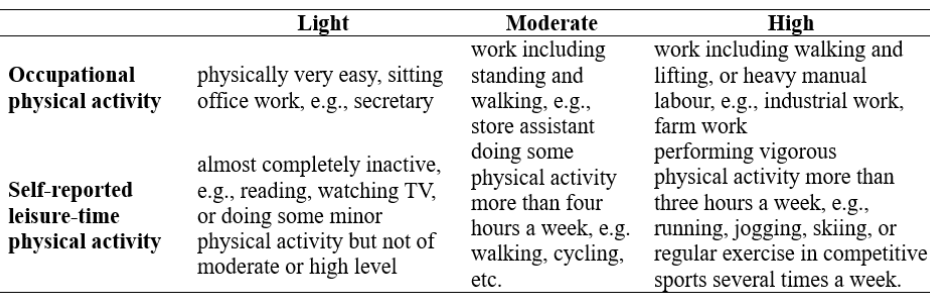
Figure 2. Physical activity